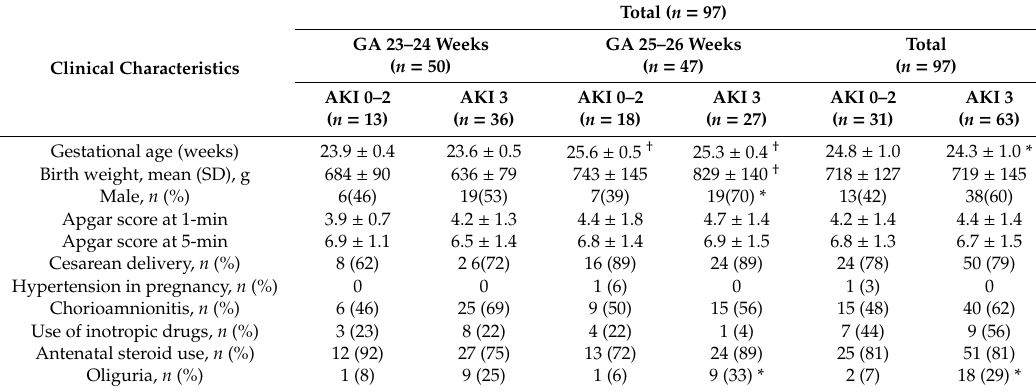
Table 2. Demographics and clinical characteristics of EPT in period II: Stage 0–2 AKI vs. stage 3 AKI.